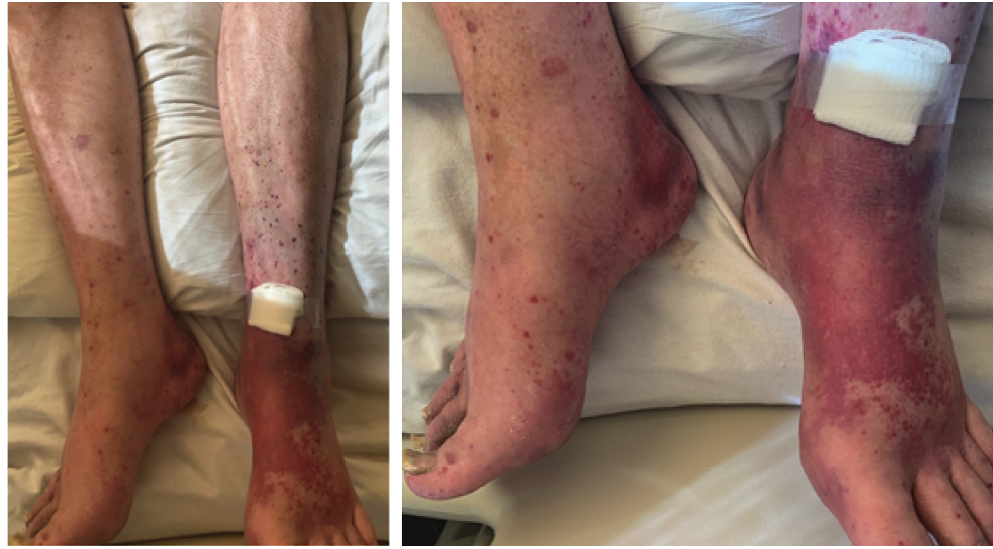
Figure 2: Status post skin biopsy, initiation of pulse-dose